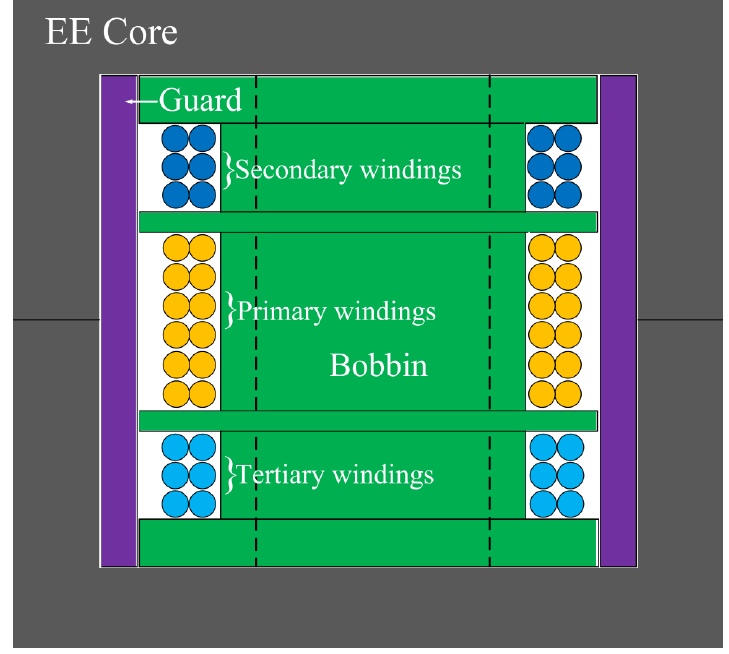
Figure 9. Arrangement of windings and structure of